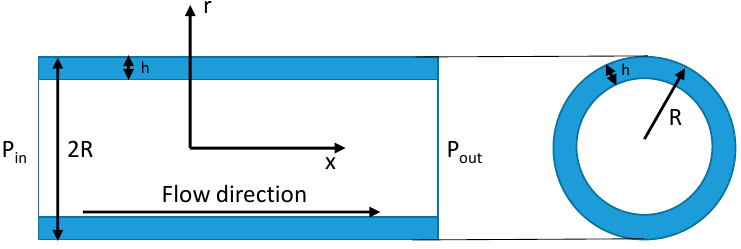
Figure 1. Scheme of fluid flow in lateral placed micro tube.